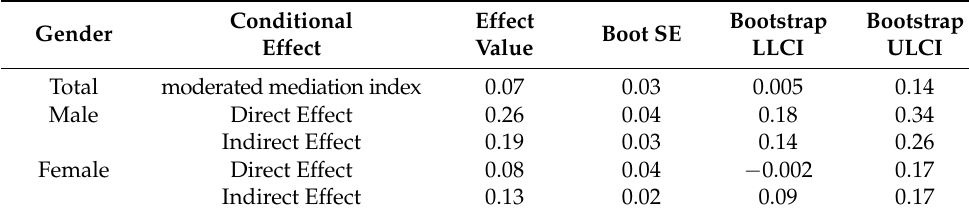
Figure 2. The association between boredom proneness and online deviant behaviors for gender.